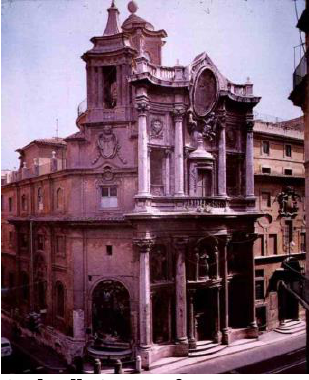
Fig. 20 San Carlo alle Quattro fontane, Rome (Borromini,